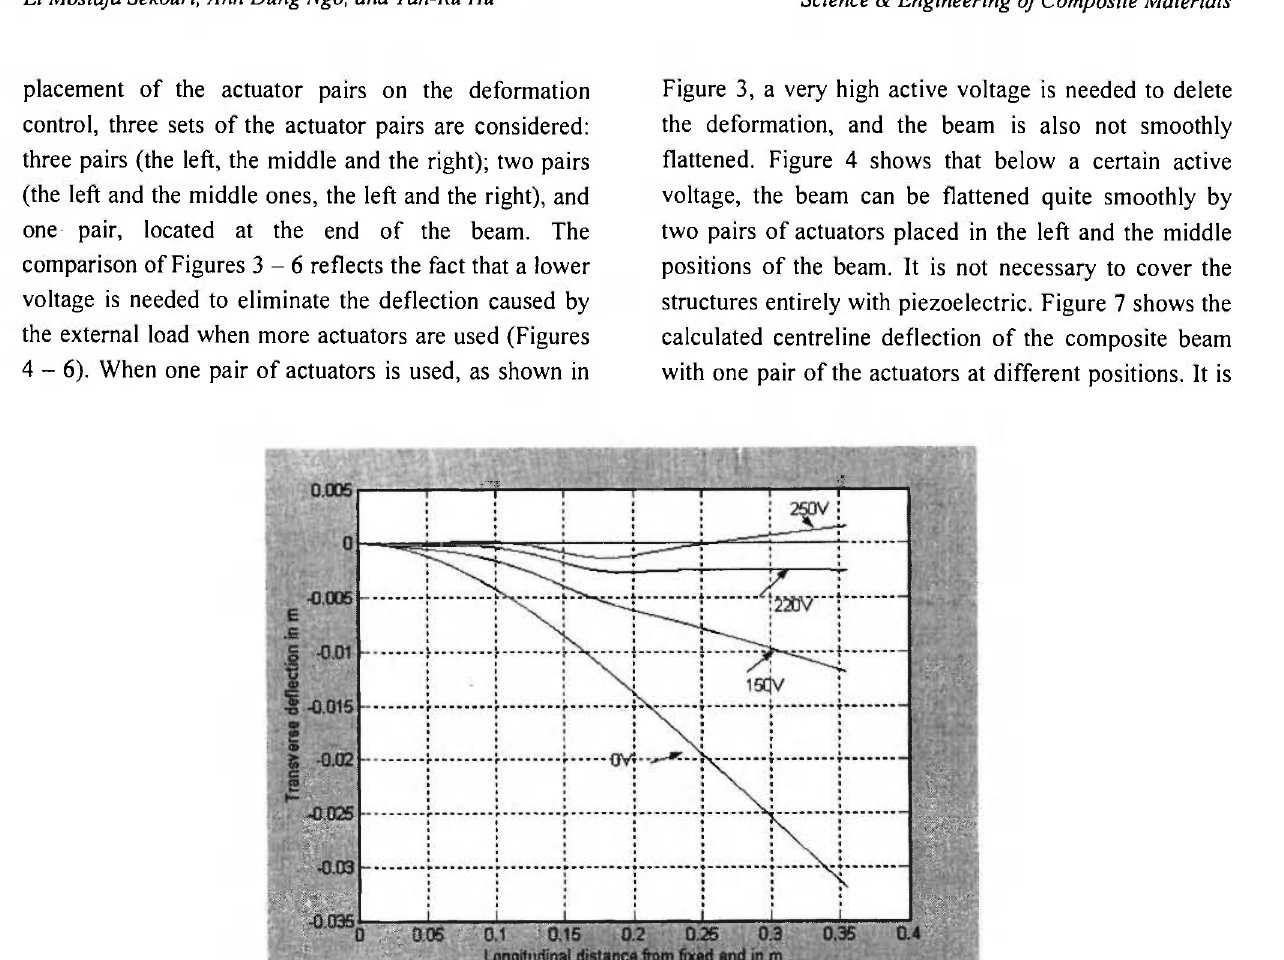
Fig. 4: Two pairs of actuators located at the left end and at the middle of the beam.